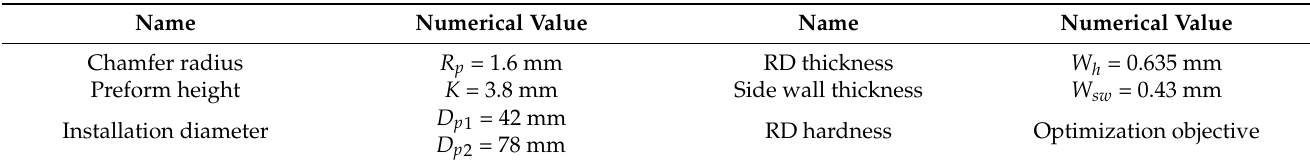
Table 2. Main parameters of rolling diaphragm.